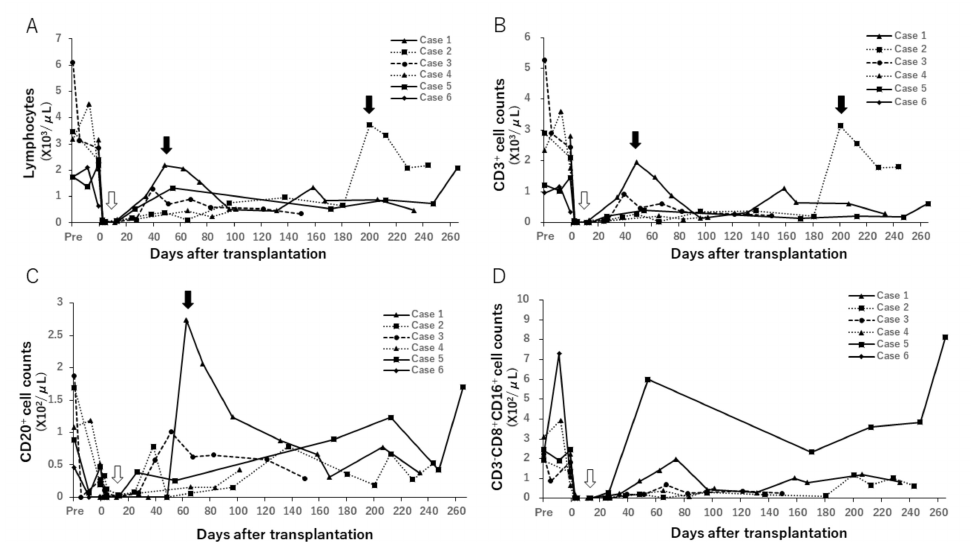
Figure 8. Changes in peripheral lymphocyte counts. Peripheral lymphocyte ( A ), CD3 + ( B ), CD20 + ( C ) and NK cell ( D ) counts decreased after induction treatment with antithymocyte globulin (ATG) and rituximab (white arrow). CD3 + and CD20 + counts gradually increased following induction treatment, and then increased remarkably with rejection in some cases (black arrow). In case 2, lymphocyte and CD3 + cell counts elevated on POD 200 with low-grade cellular rejection caused by cessation of TAC and MMF due to treatment for PTLD, while CD20 + was suppressed due to administering of rituximab for